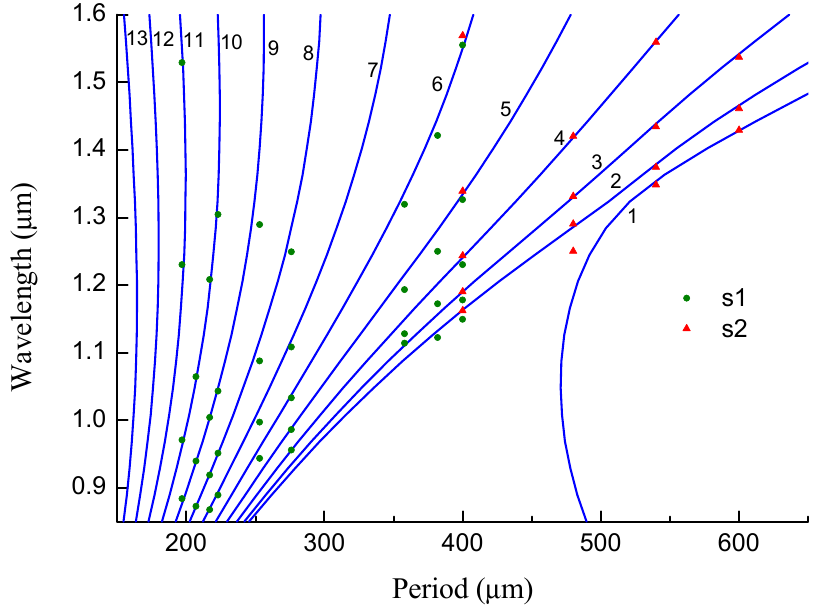
Figure 5. Resonance wavelengths of LPFGs vs. grating period for different LP 1 j cladding modes in the SMF-28 fiber.